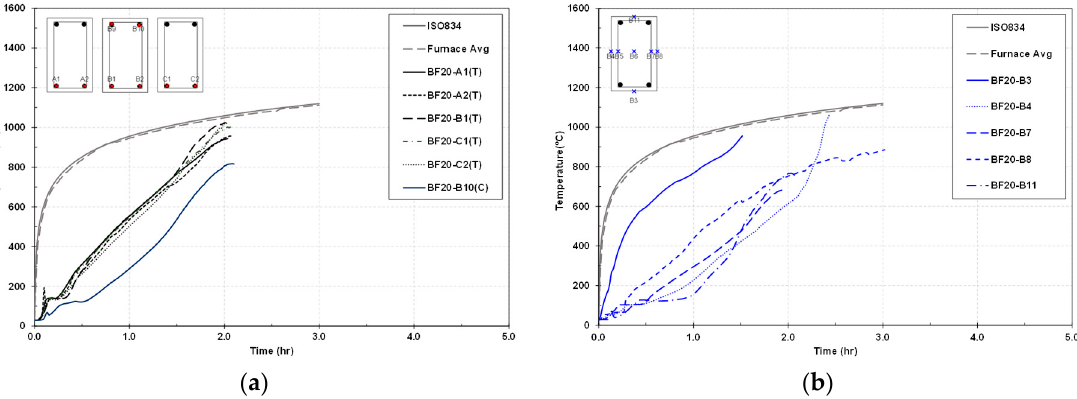
Figure 9. Temperature versus time relationship in the beam RF20. ( a ) Reinforcement; ( b ) Concrete.